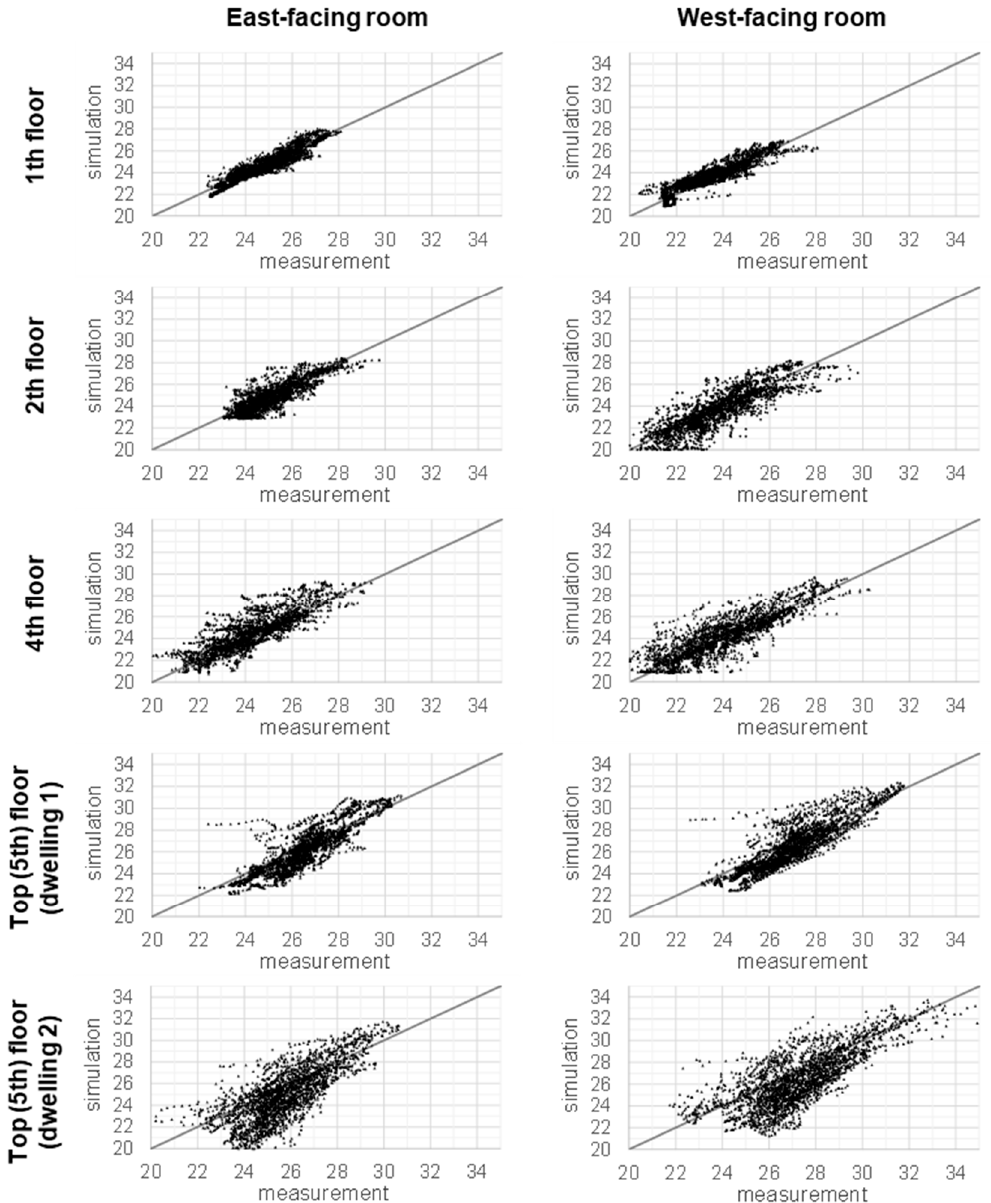
Figure A4. Plots of hourly resolved measured (monitored) room temperature ( x -axis) to simulated room temperature ( y -axis) profiles for all rooms monitored in the GZH dwellings during the period (from 3 June until 8 September 2019) for the calibrated BPS including the presence of the residents. The grey line represents the ideal curve where the simulated room temperature is equal to the measured one. The statistic indexes regarding these plots can be found in Table 3.